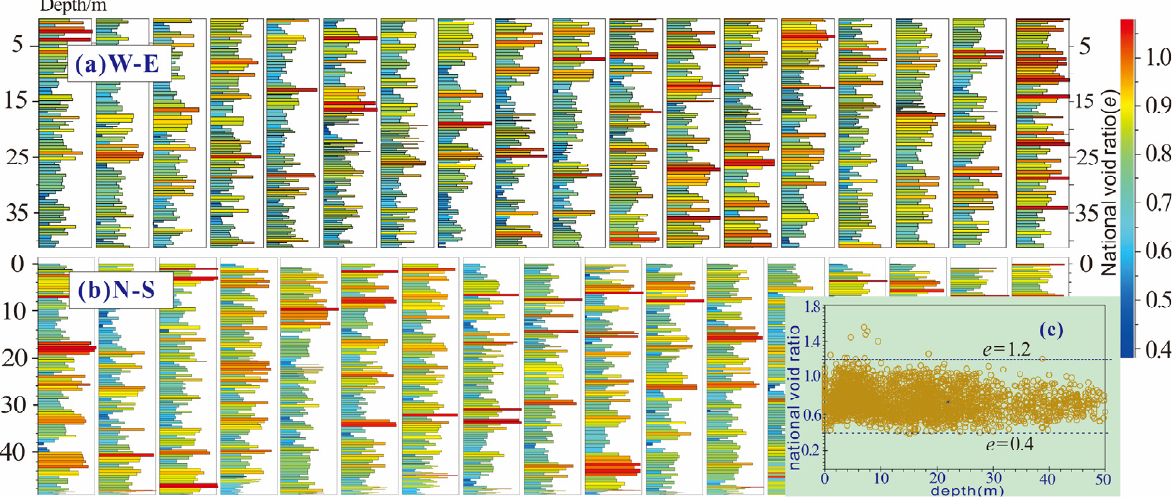
Figure 13. The initial void ratio of subsoils ( a , b ) in west–east (WE18) and north–south (NS12) orientations, respectively; ( c ) all measured results vs. the depth.